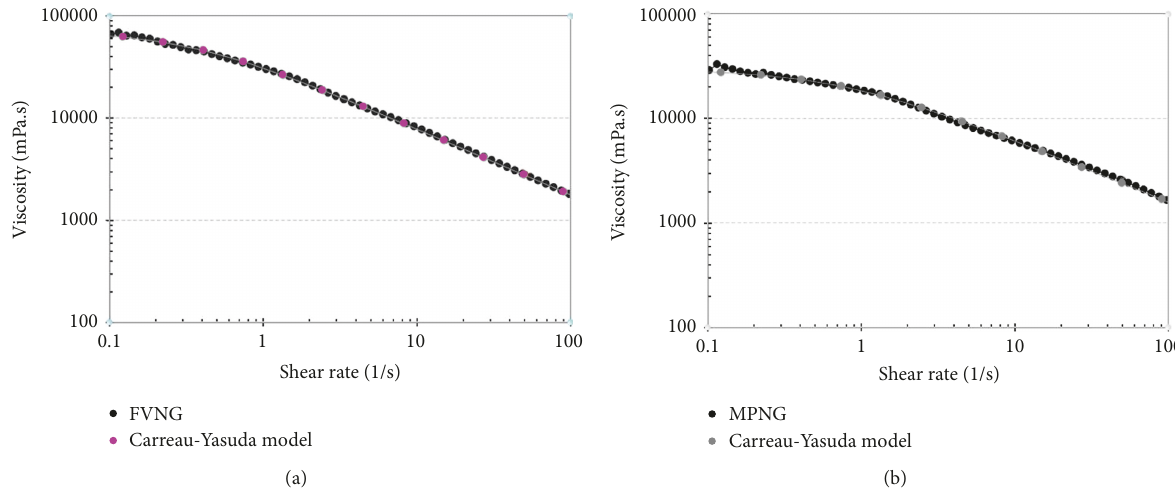
Figure 3: Viscosity of the nanogels containing (a) F. vulgare EO (FVNG) and (b) M. piperita EO (MPNG) at different shear rates fully fitted with the Carreau–Yasuda model.